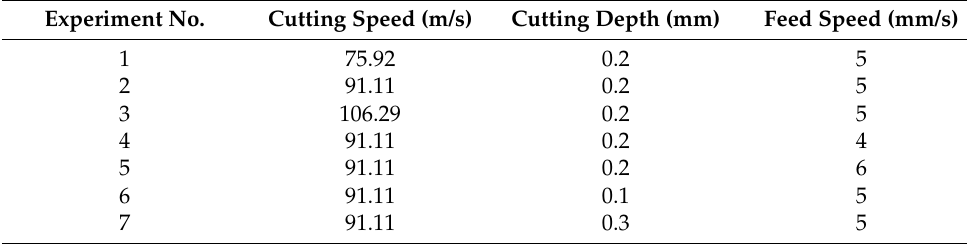
Table 3. Process parameters in the single factor